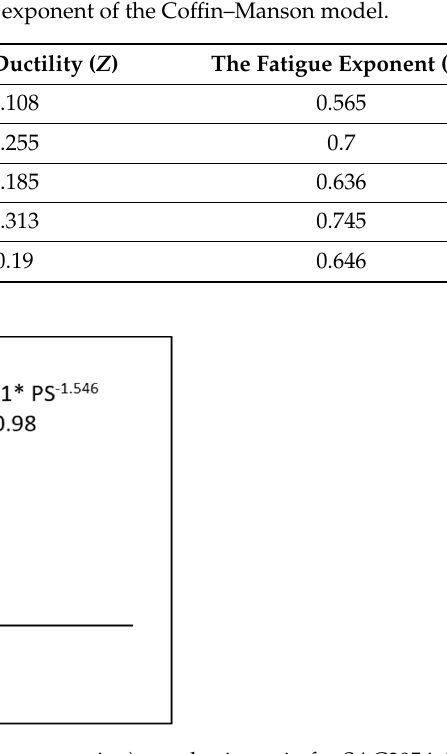
Table 2. Fatigue ductility coefficient and fatigue exponent of the Coffin–Manson model.